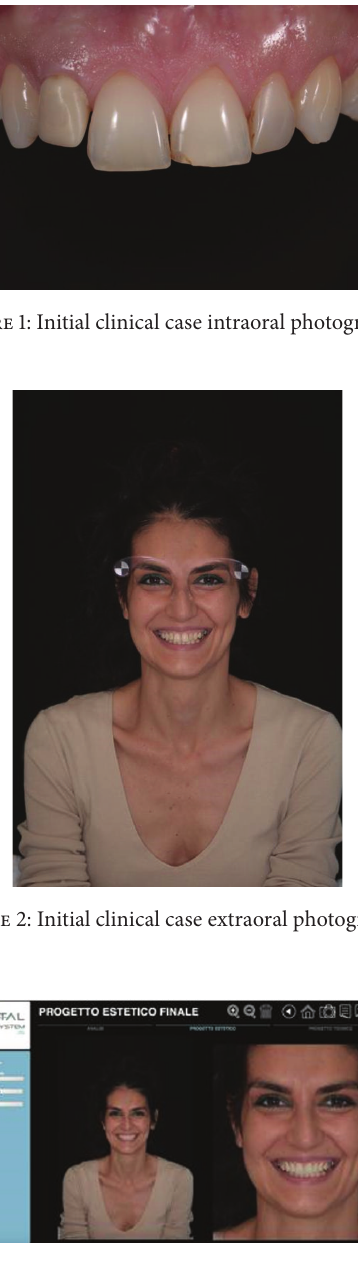
Figure 3: Digital smile design into Digital Smile System